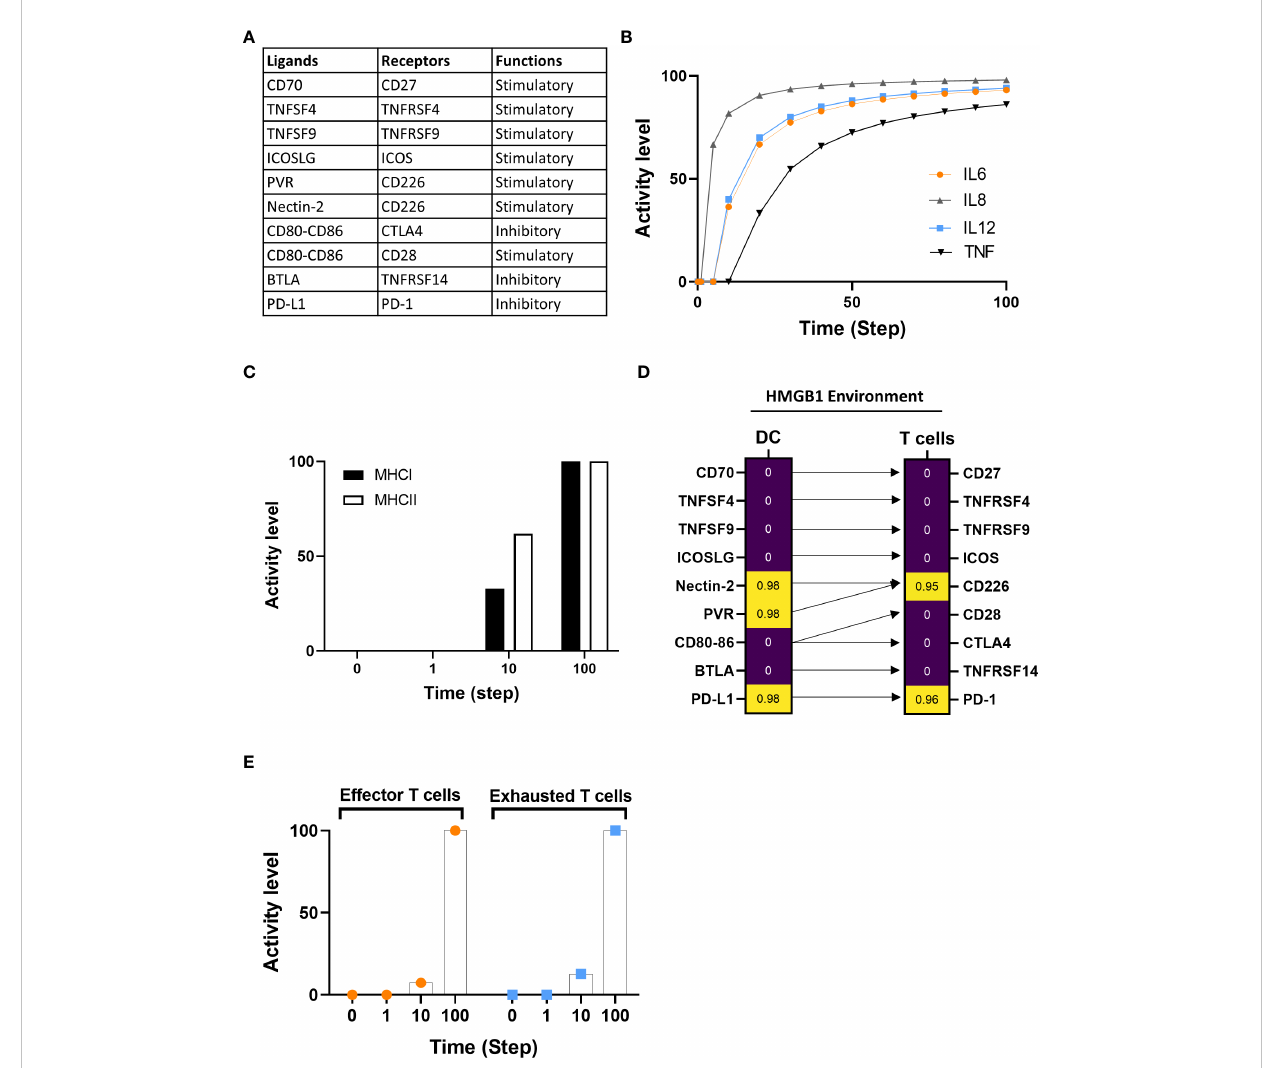
FIGURE 5 Investigation of DCs-T cells crosstalk under an HMGB1 tumor environment. (A) The table indicates the immune checkpoint pairing between ligands and associated receptors along with the type of functions (stimulatory or inhibitory). (B) Assessment of IL6, IL8, IL12, and TNF cytokine expression under HMGB1 environment. (C) The activity level of MHC classes I and II are between 0 and 10, with the time 100 added at the fi nal expression of both classes. (D) Standardized regression coef fi cient (SRC) between ligands and associated receptors on DC and T cells with HMGB1 environment. High and low SRC presented with yellow and purple, respectively. Arrows link the ligands to their respective receptors. (E) Time course of effector T and exhausted T cells activity level expression at a probability of activation at time steps 0, 1, 10, and 100 in HMGB1